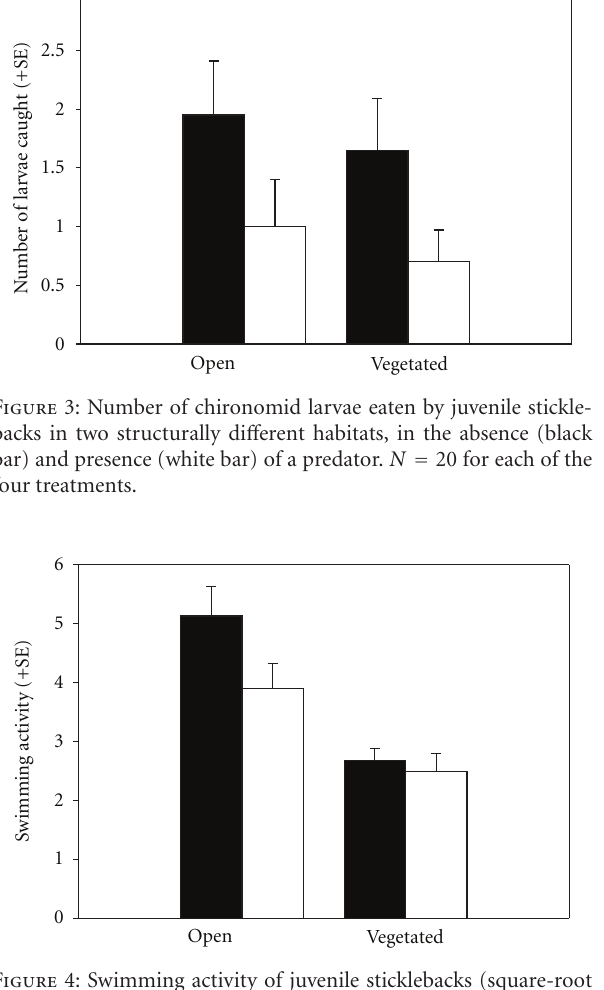
Figure 4: Swimming activity of juvenile sticklebacks (square-root transformed + 0.5) + SE in two structurally di ff erent habitats in the absence (black bar) and presence (white bar) of a predator. N = 20 for each of the four